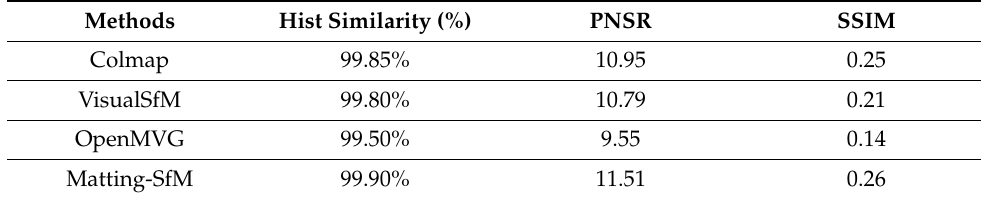
Table 1. A comparison of all of the datasets using the mathematical